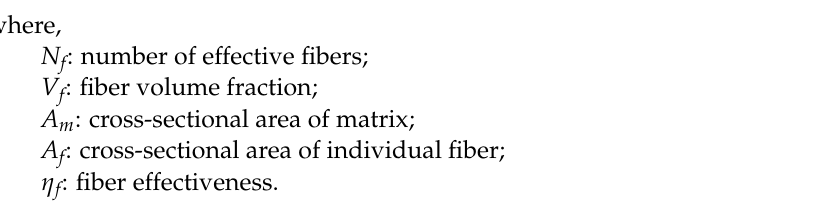
Table 6. Comparison between uniaxial tension test results and bridging law calculation (Fc24 Series). Specimen Series